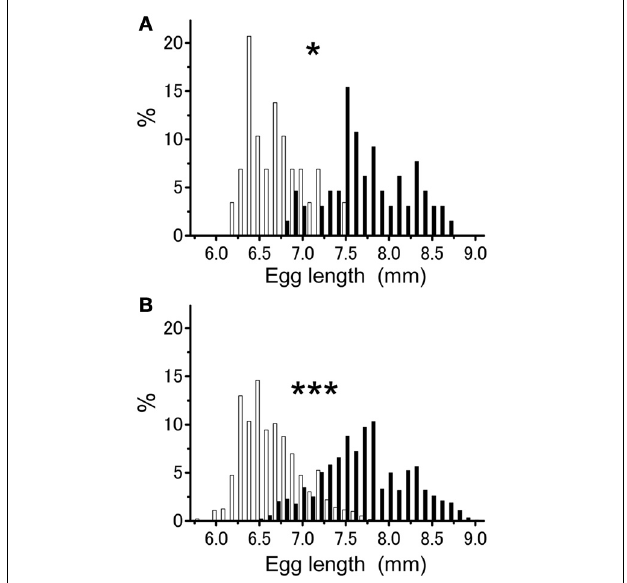
FIGURE 1 | Percentage of egg sizes within egg pods (A) and for individual eggs (B) produced by the females obtained from either isolated—(white bars; egg pods n = 29, individual eggs n = 1908) or crowd-reared females (closed bars; egg pods n = 65, individual eggs n = 3660) in Schistocerca gregaria. Asterisks above the bars indicate significant difference at P < 0 . 001 by F